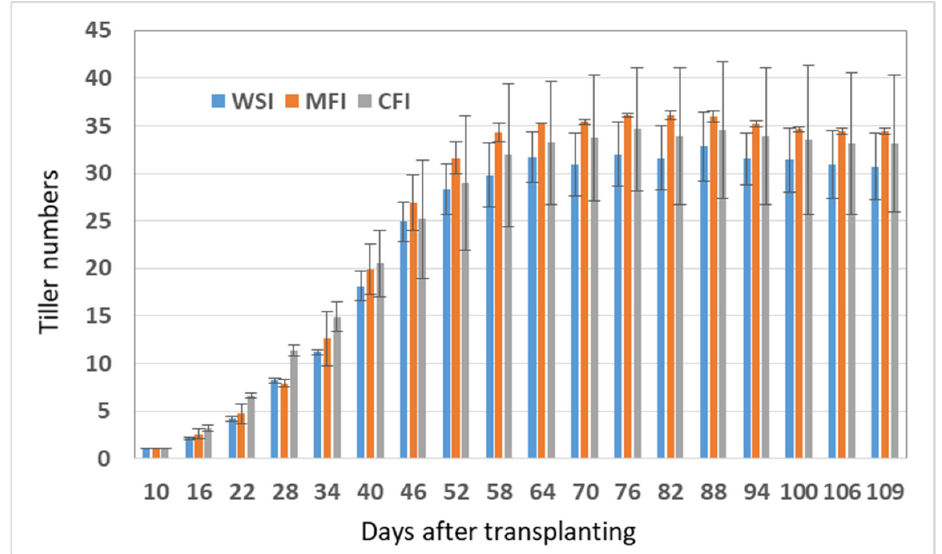
Figure 8. The Average plant height among the regimes. Comparable results in the number of tillers were found among the regimes, particu- larly in the early growth stage. At 10 DAT, the regimes produced the same number of tillers (Figure 9). A significant increase in the number of tillers occurred from the vegeta- tive growth stage (25–30 DAT). In this phase, the number of tillers was 11, 8, and 8 in the CFI, MFI, and WSI regimes, respectively. The tiller formation ended at 70 DAT in the gen- erative state, in which the paddies focused on grain filling. An appealing occurrence hap- pened at the end of the late-season stage, where the MFI regime produced more tillers than the two other regimes. The number of tillers in the MFI regime was 34. It was 3.8% and 10.8% greater than the CFI and WSI regimes, respectively. Thus, saturated soil condi- tions (water level at soil the soil surface) were more effective in tillers formation.